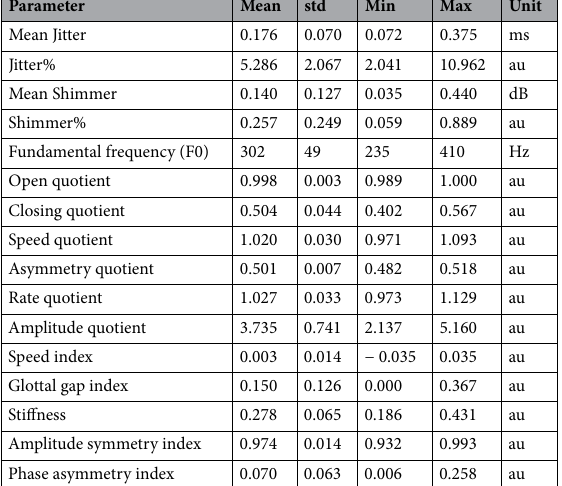
Table 2. Glottal area waveform (GAW) parameters.